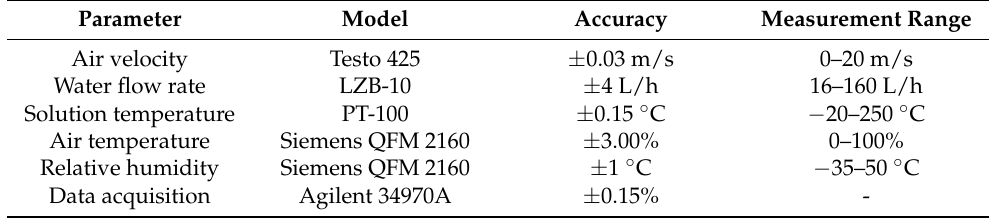
Table 3. Parameters of the experimental